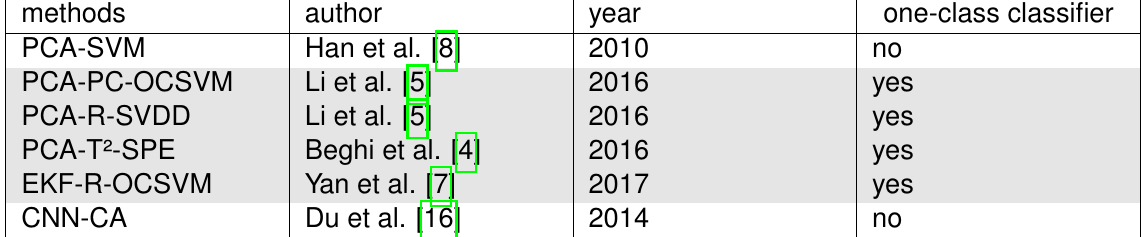
Table 1. Data-driven methods for fault detection on refrigeration